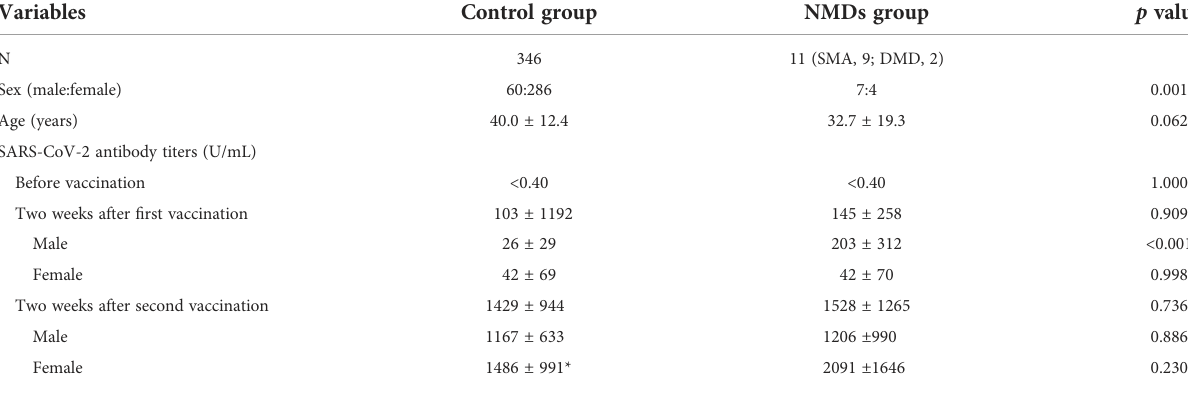
TABLE 1 Background and SARS-CoV-2 antibody titers of the control and NMDs groups.